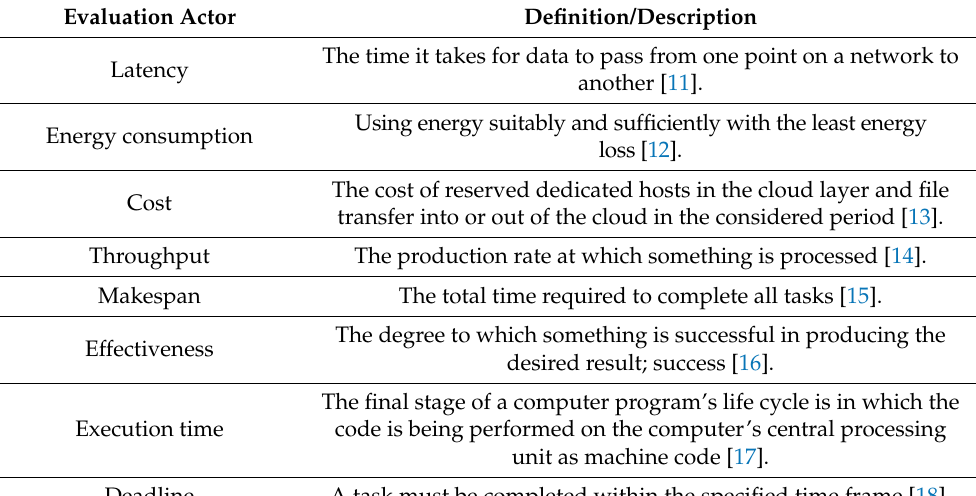
Table 1. Description of some evaluation factors used in the